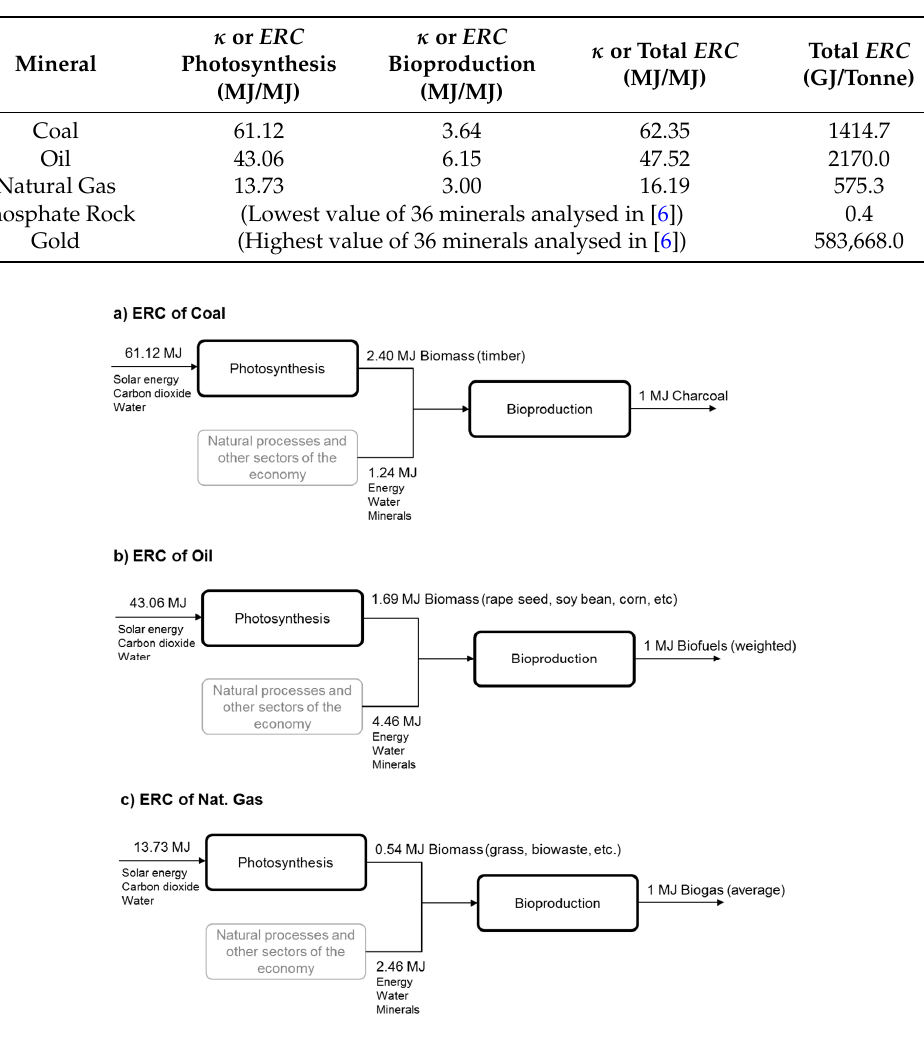
Figure 7. ERC of fossil fuels from solar radiation to fuel.